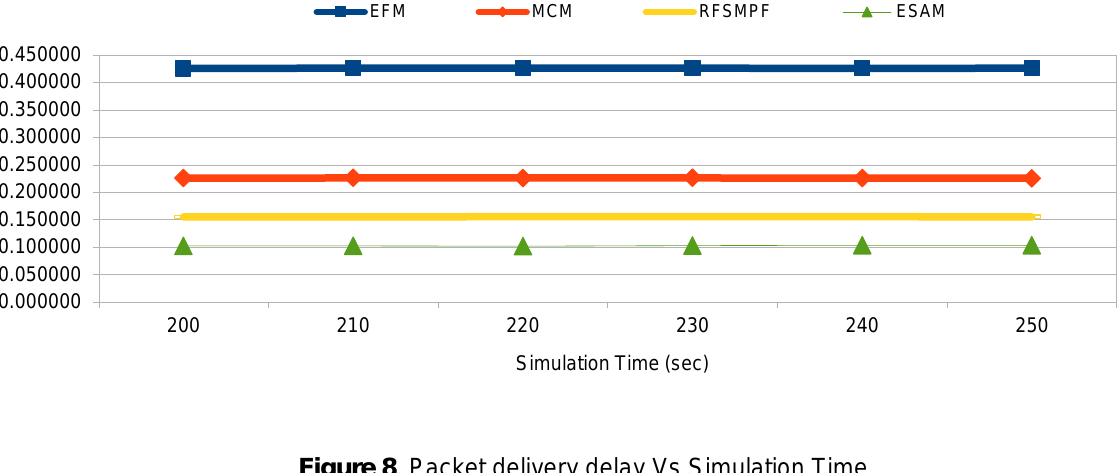
Figure 8 . Packet delivery delay Vs Simulation Time